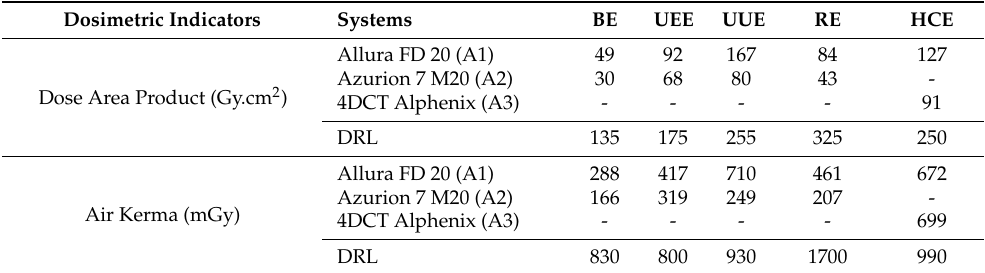
Table 5. Comparison of dosimetric indicators with the reference levels proposed by Etard et al.